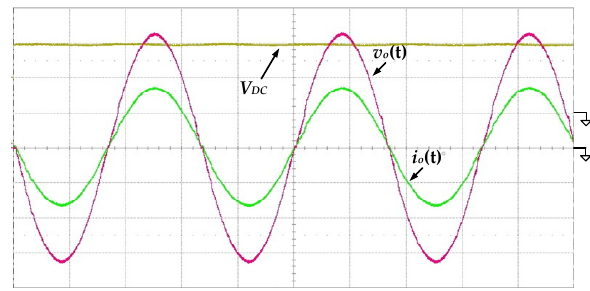
Figure 11. The measured waveforms of the output voltage v o ( t ) and output current i o ( t ) at 100 V input voltage and 500 W output load ( v o ( t ): 100 V/div; i o ( t ): 2 A/div; V DC : 100 V/div; time: 5 ms/div).